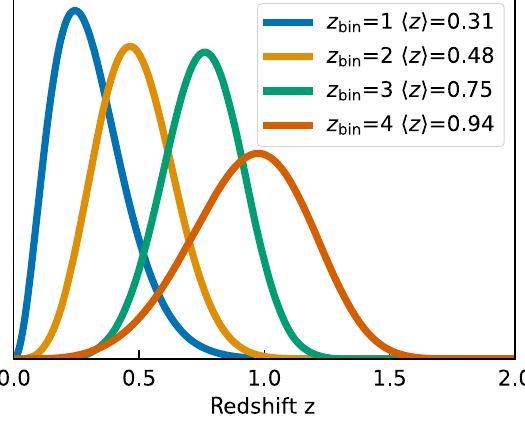
FIG. 7. Redshift bins used in this work.